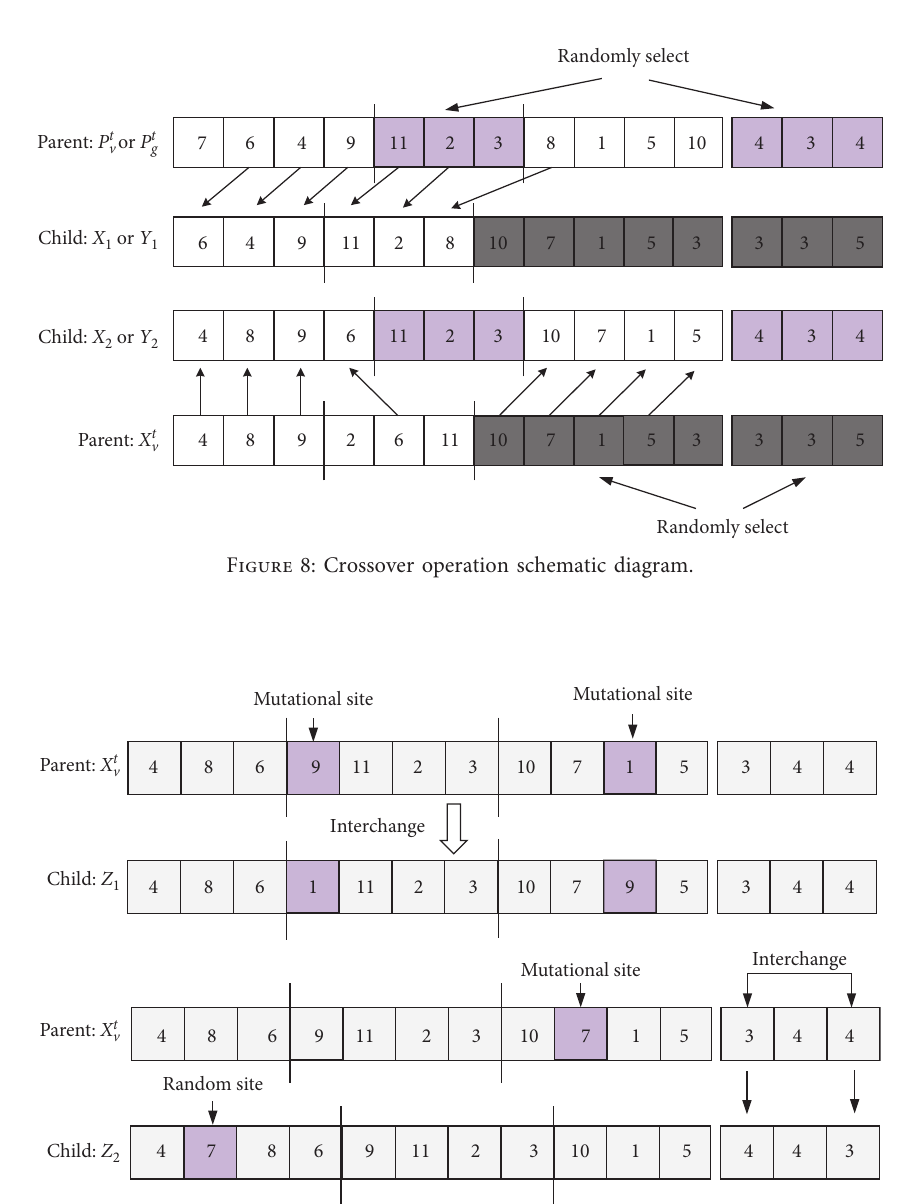
Figure 9: Mutation operation schematic